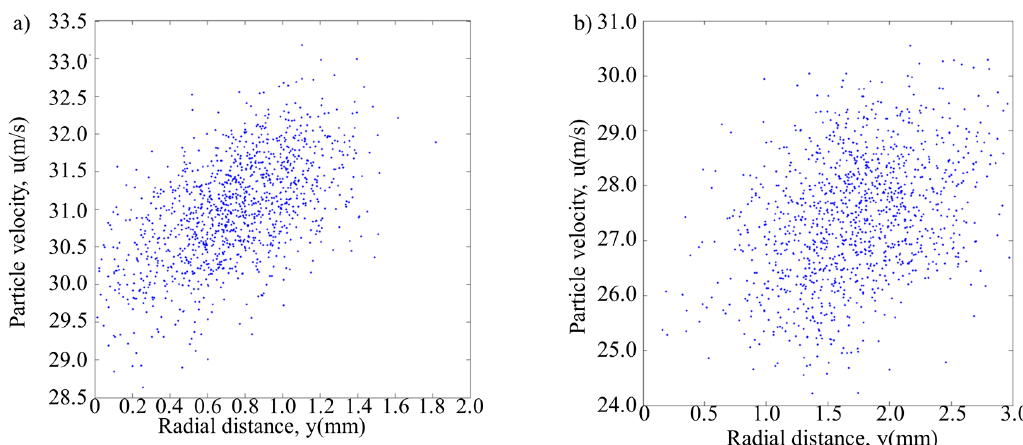
Figure 12. The distribution diagram of powder velocity. ( a ) Powder velocity in laser DED and ( b ) powder velocity in the hybrid process.